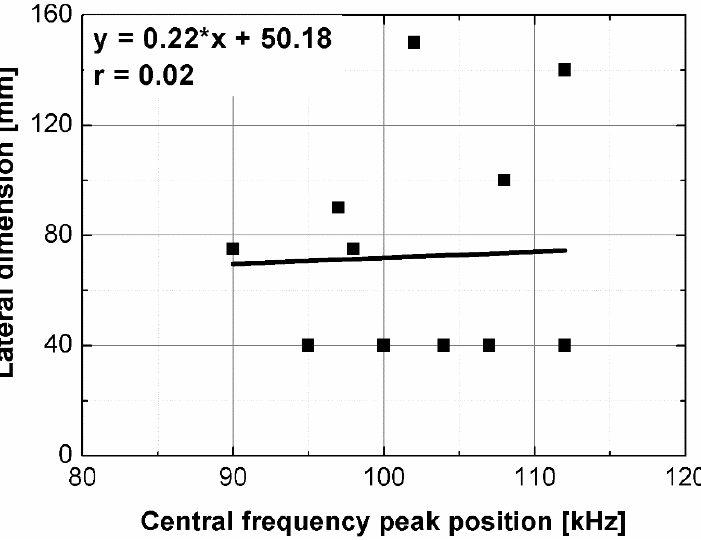
Figure 11. Path length plotted against position of central frequency peak.